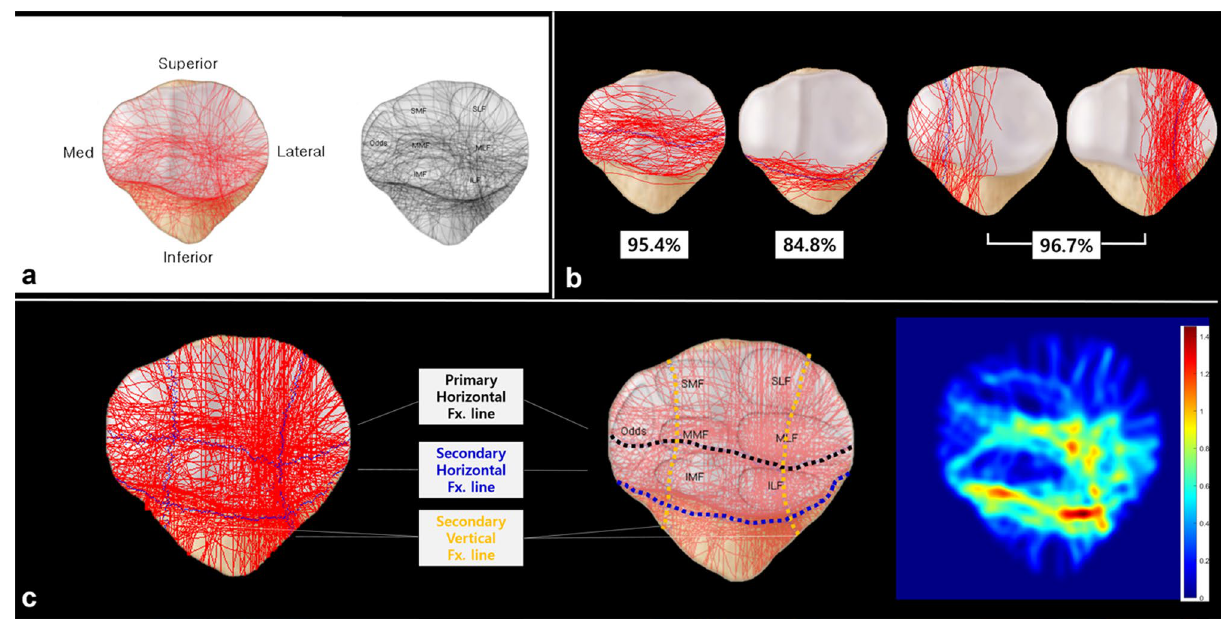
Figure 5. Coronal articular surface fracture mapping. This picture shows the fracture lines of all 66 superimposed fractures ( a ). The denominated fracture lines as a ‘Primary horizontal’, ‘Secondary horizontal’ and medial and lateral ‘Secondary vertical’ fracture line were digitized and the average value of each fracture line (blue dotted line) was calculated separately ( b ). Primary horizontal fracture lines (black dotted lines), secondary horizontal fracture lines (blue dotted lines), and medial and lateral secondary vertical fracture lines (yellow dotted lines) were deemed to be major fracture lines ( c